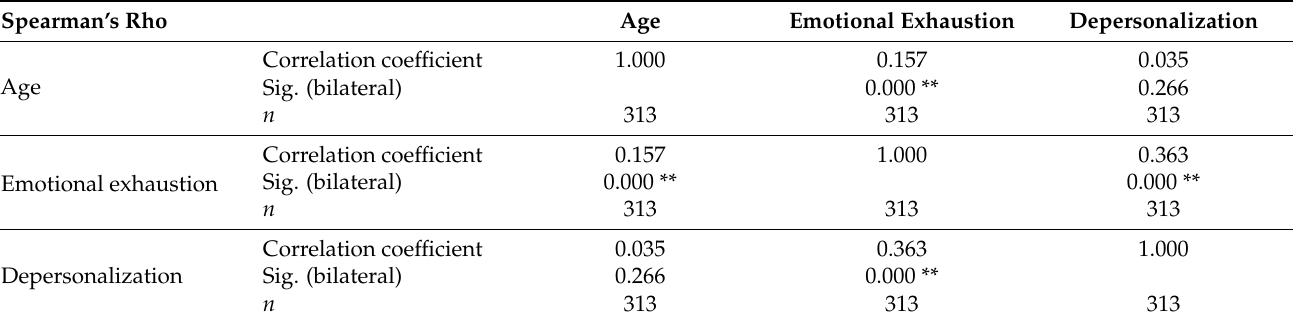
Table 2. Spearman’s Rho correlation for the variables of depersonalization and emotional exhaustion with